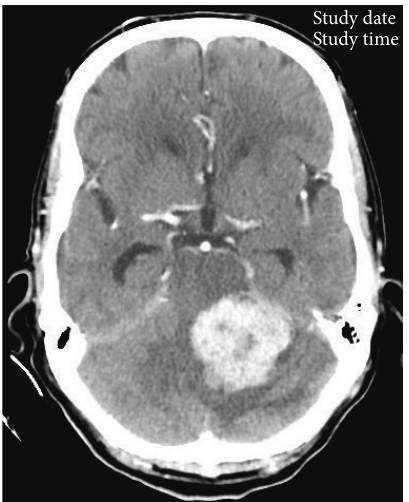
Figure 3: Computed tomography of brain (axial view) showing a 3.2 × 3.7 cm homogeneous contrast enhancing mass in the inferior vermis with extension into the left cerebellar hemisphere and brainstem causing hydrocephalus (the second